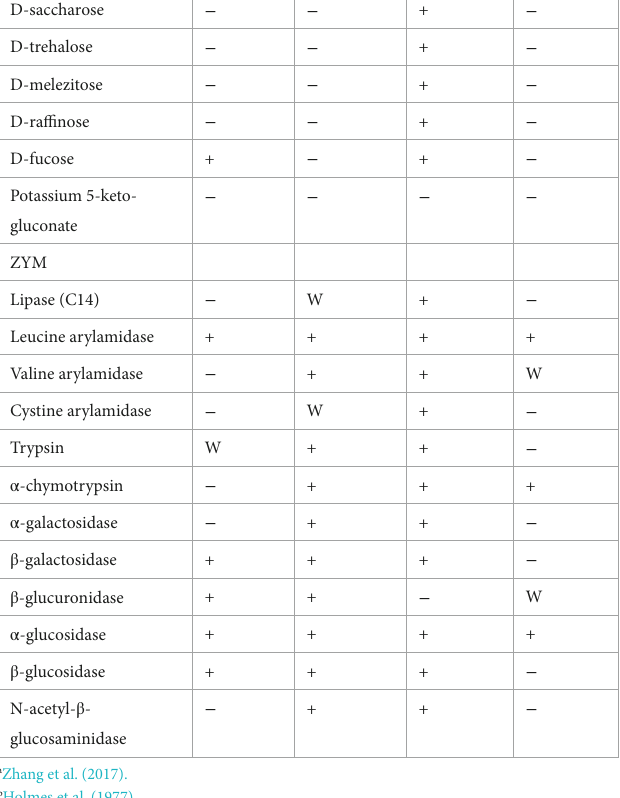
TABLE 1 Differential physiological and biochemical characteristics of strain AK-PDB1-5 T from closely related type strains.